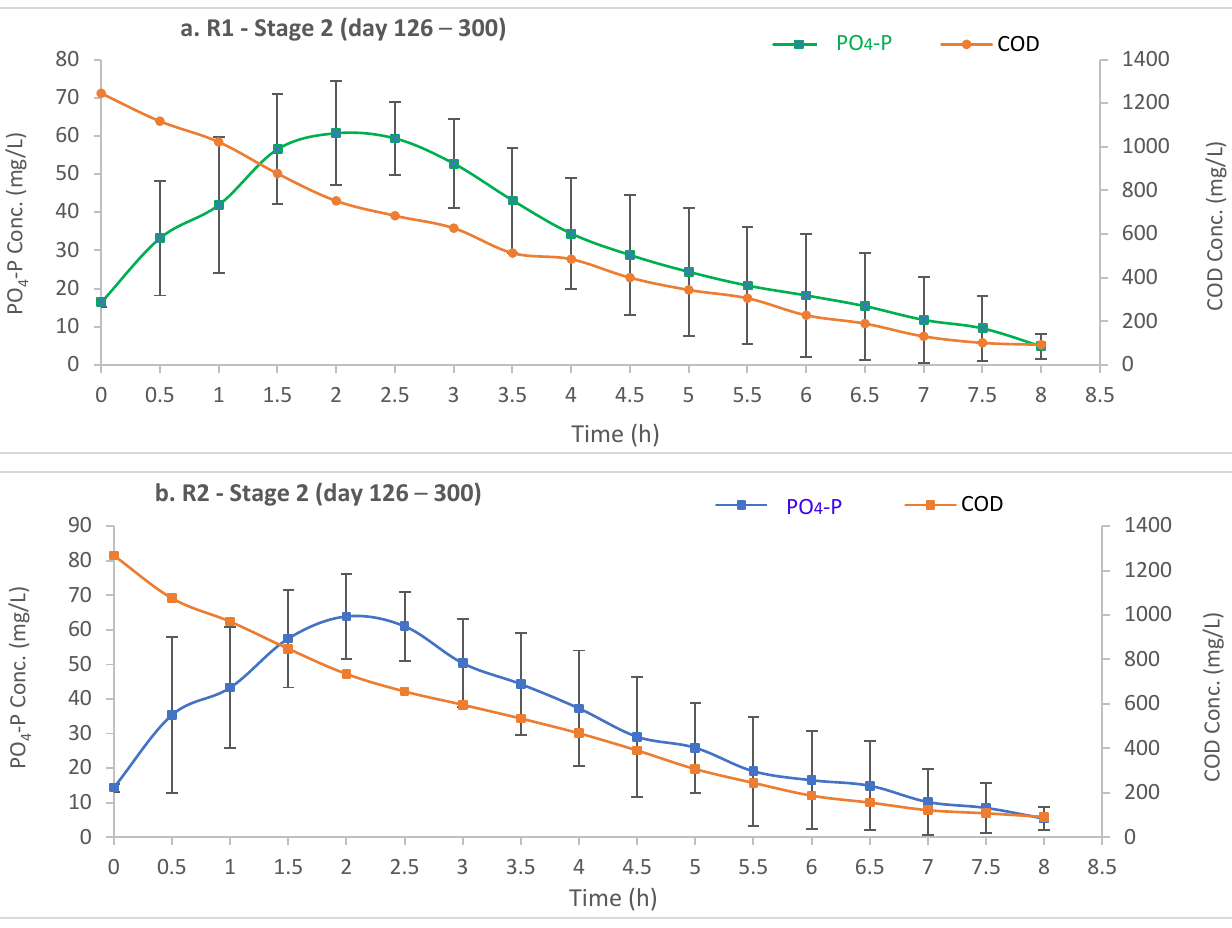
Figure 6. Phosphorus and COD removal through a typical cycle during stage II in ( a ) R1 and ( b ) R2.